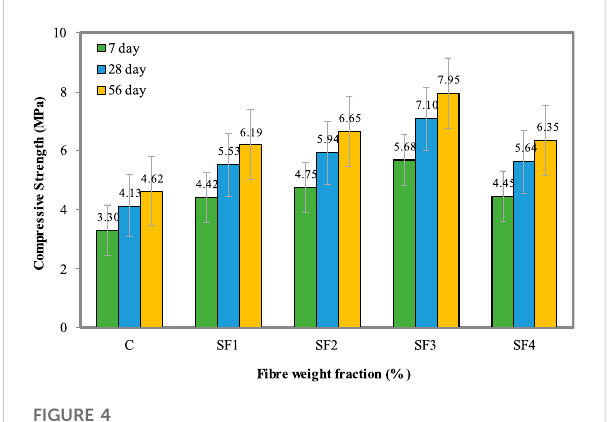
FIGURE 6 Compressive strength of 1,600 kg/m 3 FC density with varying weight fractions of